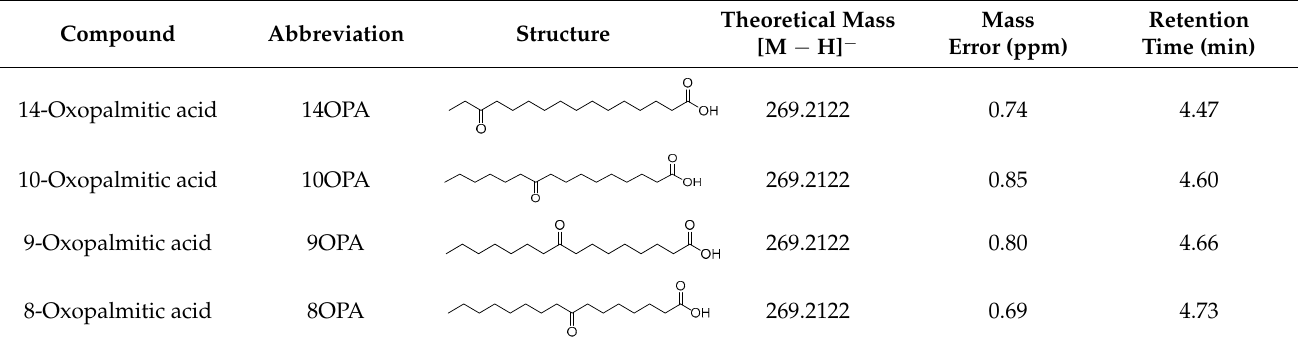
Table 1. Oxo fatty acid standards used in the chromatographic method.